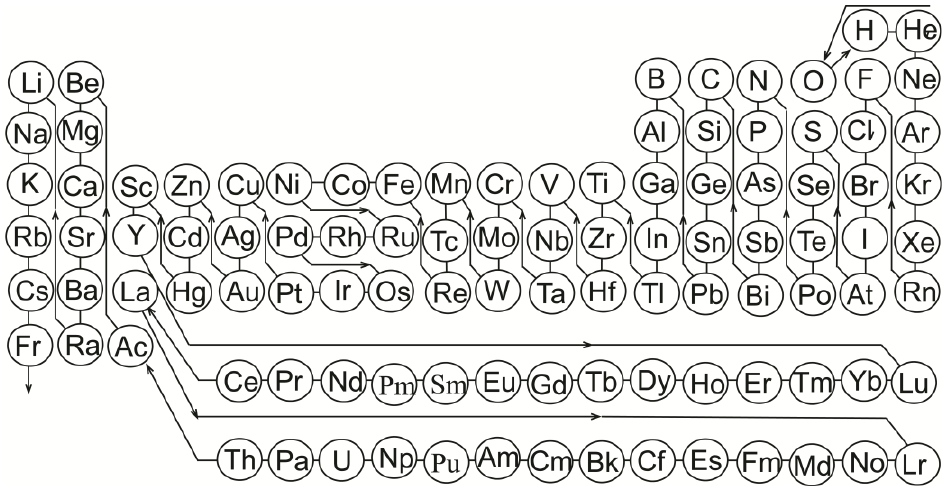
Figure 1. Thermochemical sequence of chemical elements and corresponding single-component systems.